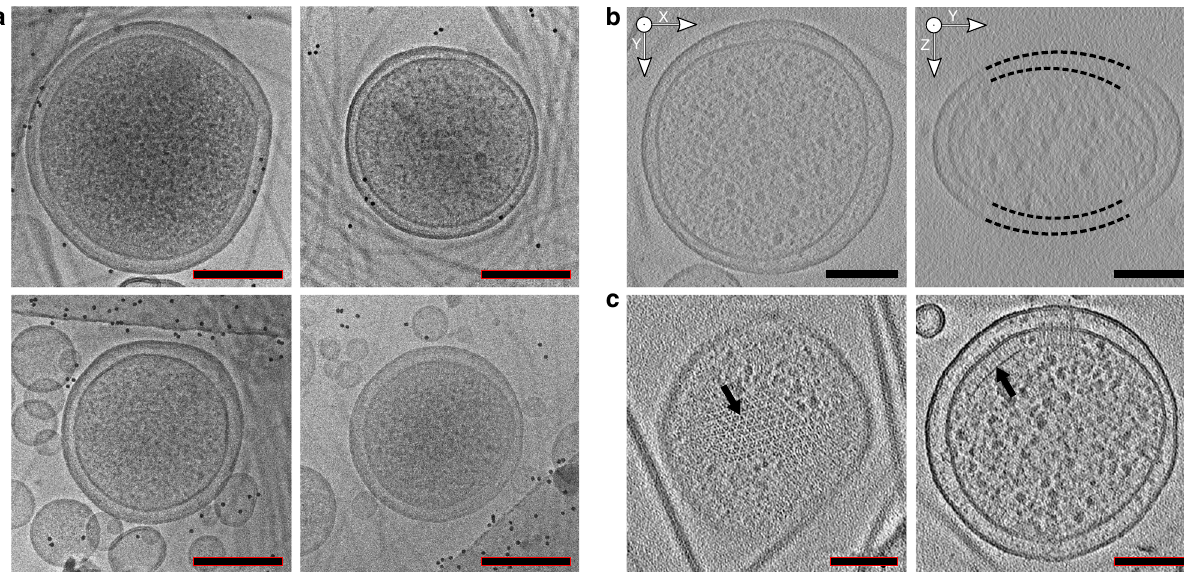
Fig. 2 WM4196 minicells are suitable for high-resolution analysis of chemoreceptor arrays. a Representative electron micrographs showing healthy looking WM4196 minicells. b — left XY slice and b — right YZ slices through tomograms of WM4196 minicells showing that they appear fl attened in vitreous ice, yielding thin samples suitable for cryo-ET. Black dotted lines are used to show membrane positions which are not clear in the images due to missing- wedge effects from tomographic reconstruction. c slices through tomograms of WM4196 minicells exhibiting presence of chemoreceptor arrays aligned both perpendicular (left) and parallel (right) to the electron beam. Scale bar is 100 nm in all